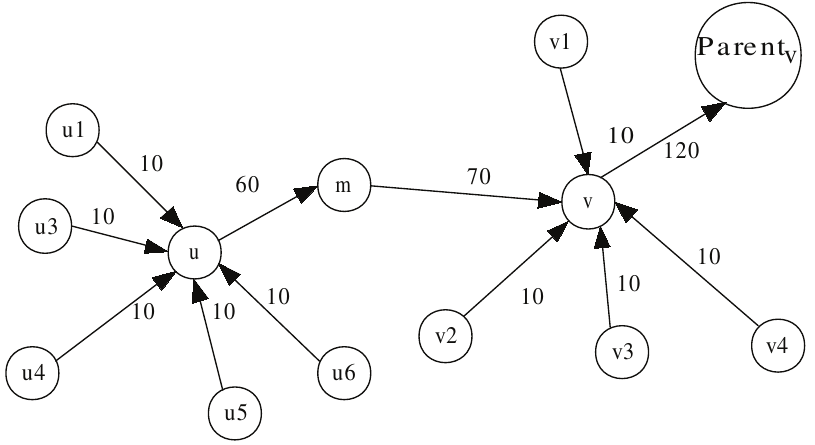
Figure 2. Flow conservation